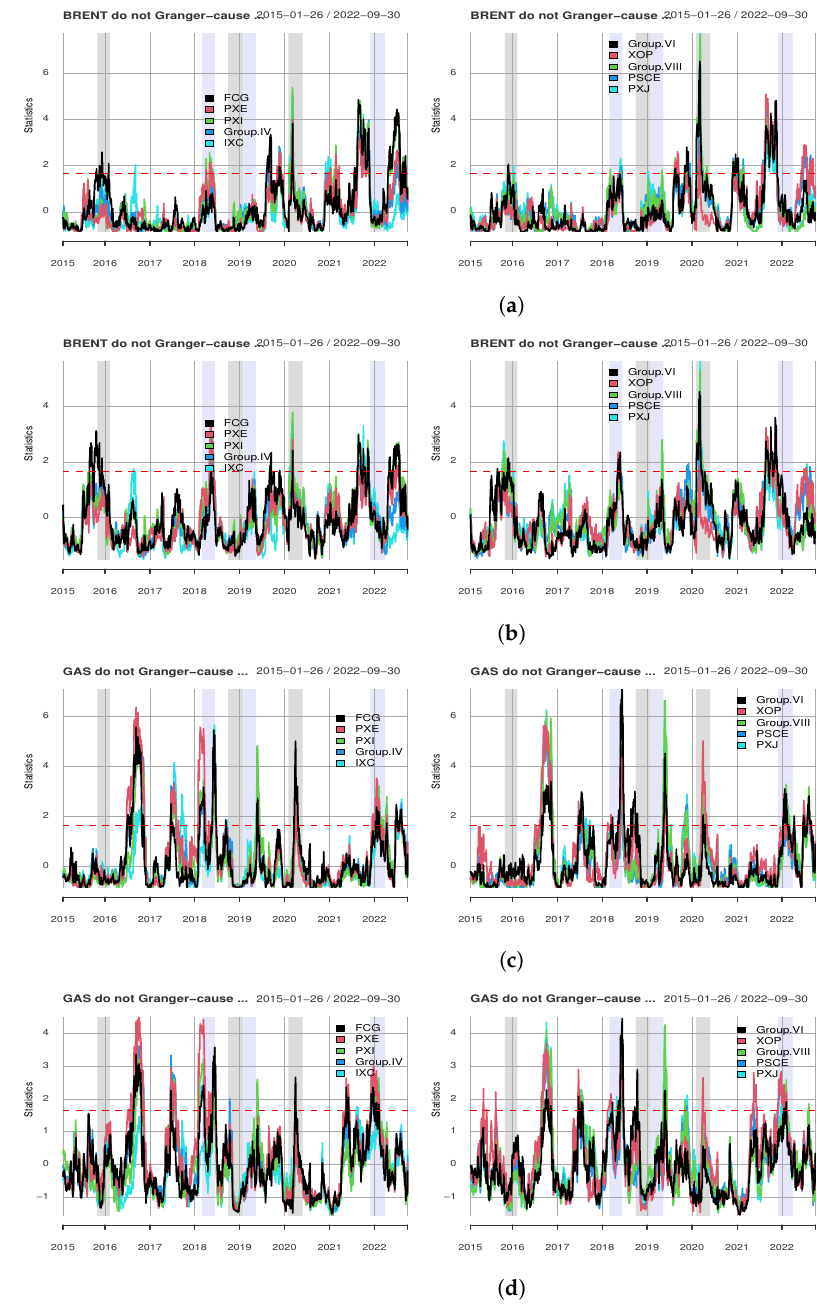
Figure A5. Rolling Hong tests between crude oil, gas, and ETFs (causality-in-mean) for different integer M . ( a ) M = 3. ( b ) M = 10. ( c ) M = 3. ( d ) M =